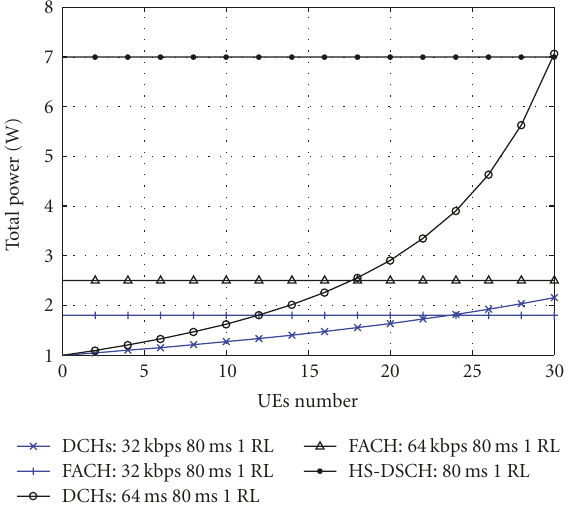
Figure 9: Node B’s Tx power for 50% coverage.